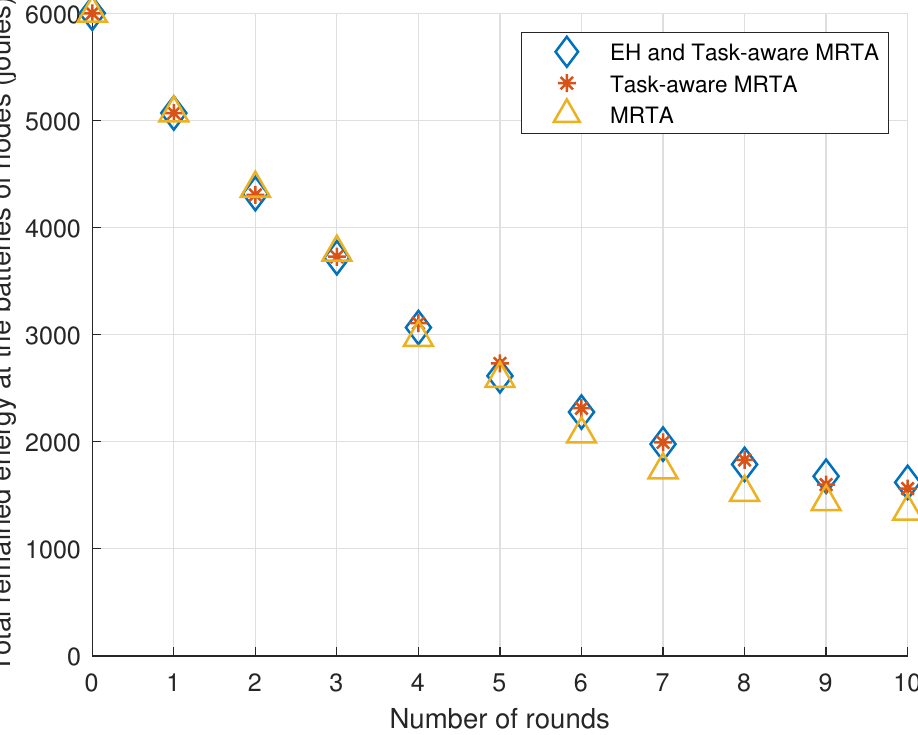
Figure 5. Total remaining energy in the batteries of the 10 robot nodes versus the number of rounds under i.i.d. EH processes.